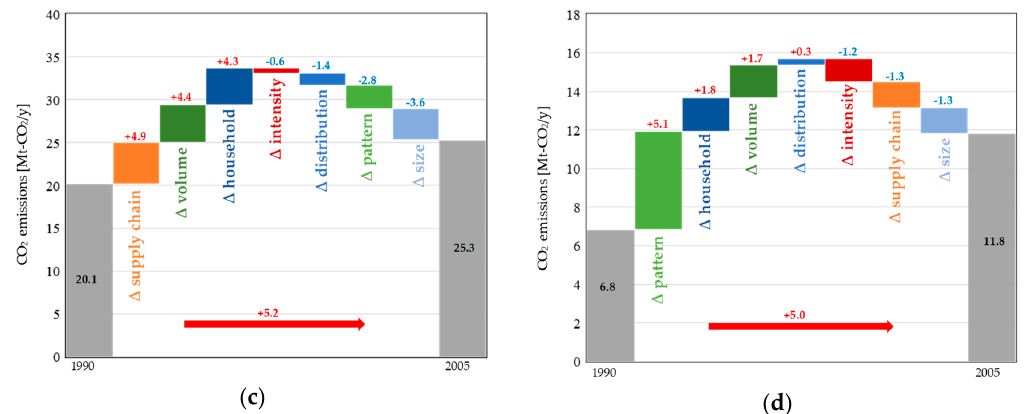
Figure 6. Structural decomposition analysis (SDA) results for indirect CO 2 emissions between 1990 and 2005 for four selected sectors. ∆ intensity is the intensity e ff ect, ∆ supply chain is the supply chain structure e ff ect, ∆ pattern is the consumption pattern e ff ect, ∆ volume is the consumption volume e ff ect, ∆ size is the household size e ff ect, ∆ distribution is the household distribution e ff ect, and ∆ household is the household number e ff ect. ( a ) Housing sector, ( b ) public transport, ( c ) private vehicles, and ( d ) medical sector .